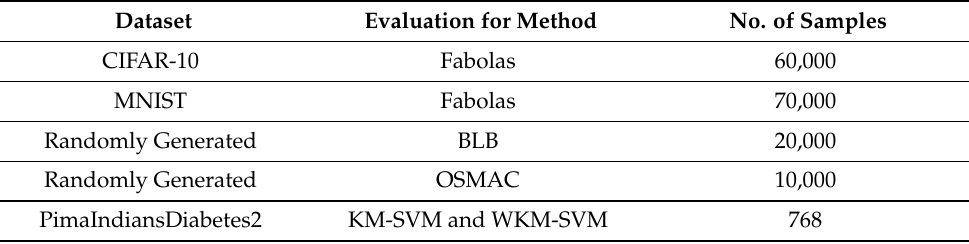
Table 2. Dataset information for each method and the number of samples contained in